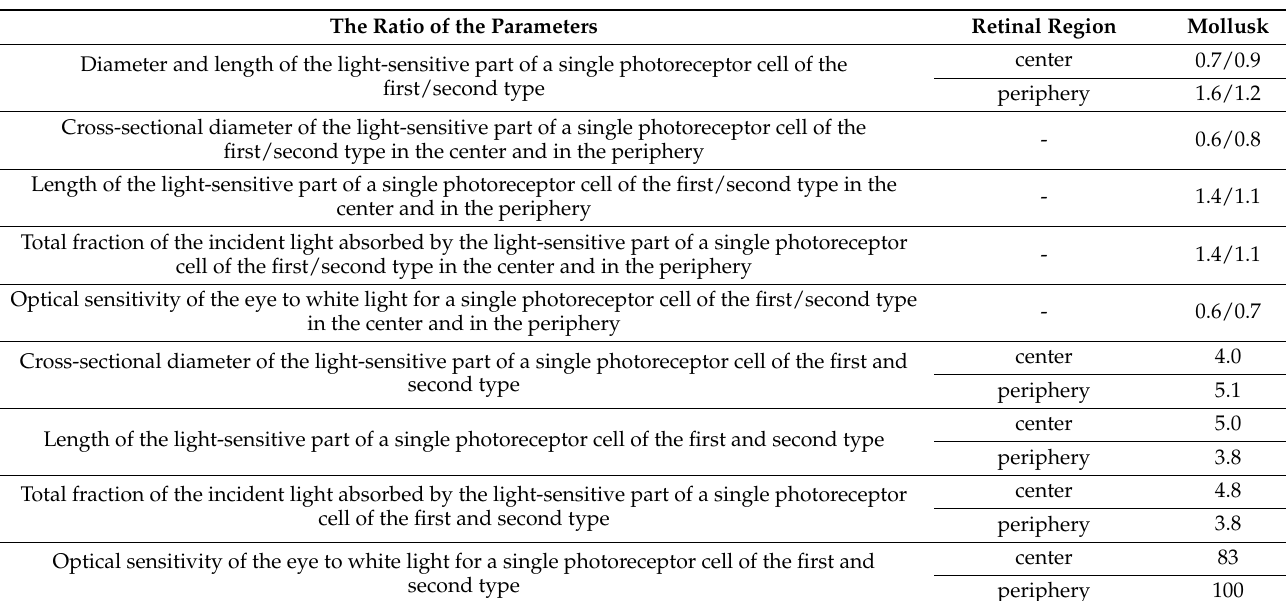
Table 2. The ratio of the parameters of the mollusk